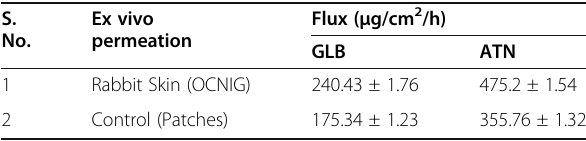
Table 6 Ex vivo permeation data of